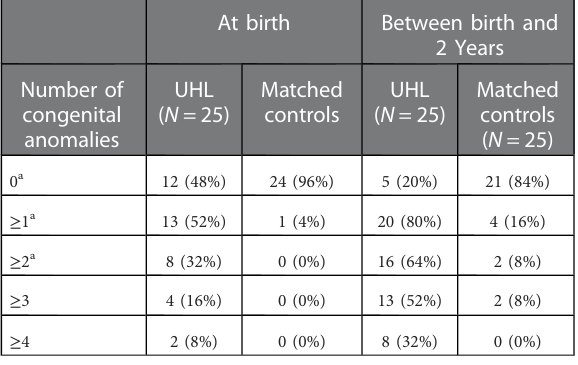
TABLE 1 Congenital anomalies detected at birth. At birth Between birth and 2 Years